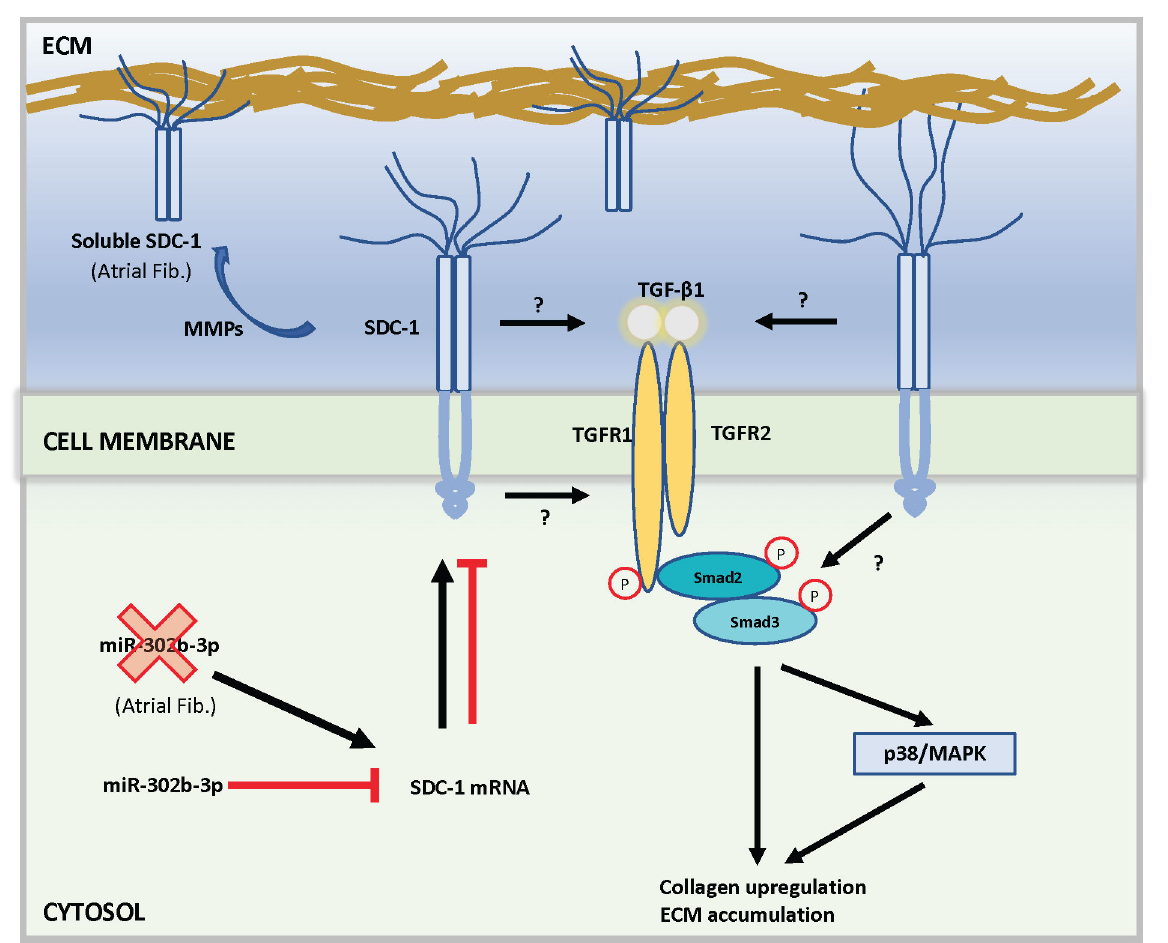
Figure 8. Proposed mechanism of SDC-1 in fibrotic remodeling of AF. Decreased levels of the miR- 302-3p family will result in increased expression of SYNDECAN-1 in atrial cardiac fibroblasts, which will stimulate TGF- β /Smad2-mediated atrial